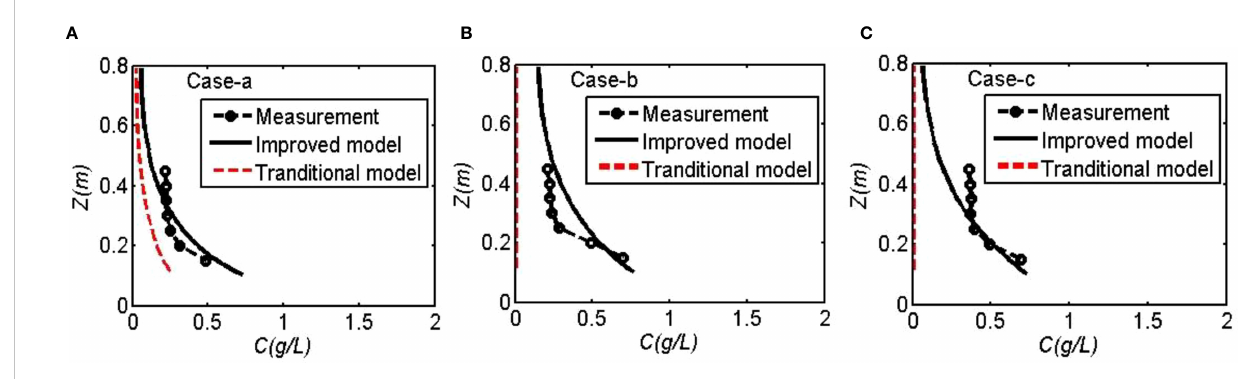
FIGURE 4 Comparisons of measured and simulated sediment concentrations in Test 1: (A) Case-a, (B) Case-b, (C)